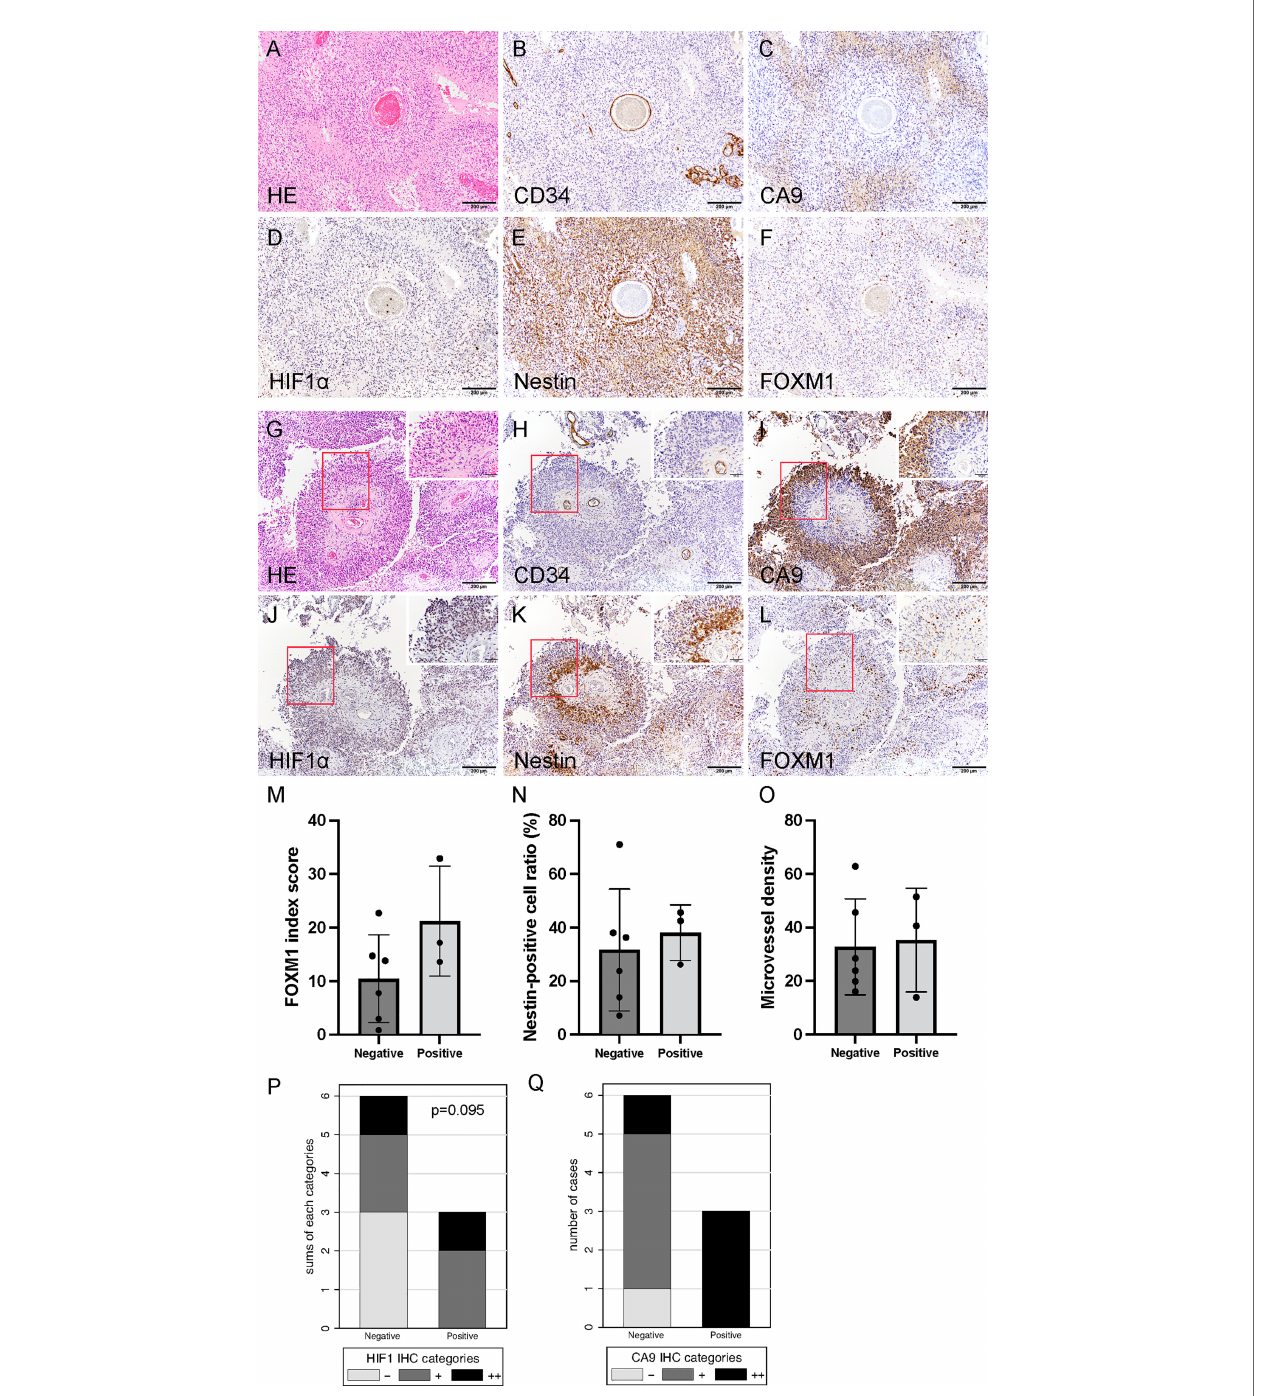
FIGURE 2 | Histological fi nding of initial tumors revealing that tumor cells predominantly accumulated around the vessels (so-called vascular co-option). Hematoxylin and eosin staining (A) and CD34 (B) , CA9 (C) , HIF-1 a (D) , nestin (E) , and FOXM1 expression (F) . Photomicrograph of immunohistochemistry (×200) (bar = 100 m m). Note that CA9 expression was found in the perinecrotic tumor cells, and the expression of HIF-1 a , nestin, and FOXM1 was widely distributed. Typical histological fi ndings of “ pseudo-papillary ” structures resembling “ vascular co-option ” in recurrent tumors. Hematoxylin and eosin staining (G) and CD34 (H) , CA9 (I) , HIF-1 a (J) , nestin (K) , and FOXM1 expression (L) . Photomicrograph of immunohistochemistry (×200; bar = 100 m m); (×400; bar = 100 m m). Note that colocalization of FOXM1- and HIF-1 a -positive cells was prominent in the perivascular area. Comparison of expression of FOXM1, MVD, and tumor oxygenation between the presence and absence of “ pseudo-papillary ” structures. FOXM1 (M) , nestin (N) , MVD (O) , CA9 (P) , and HIF-1 a expression (Q) . Error bar; standard deviation. CA9, carbonic anhydrase 9; FOXM1, Forkhead box M1; HIF-1 a , hypoxia inducible factor-1 alpha; MVD, microvessel